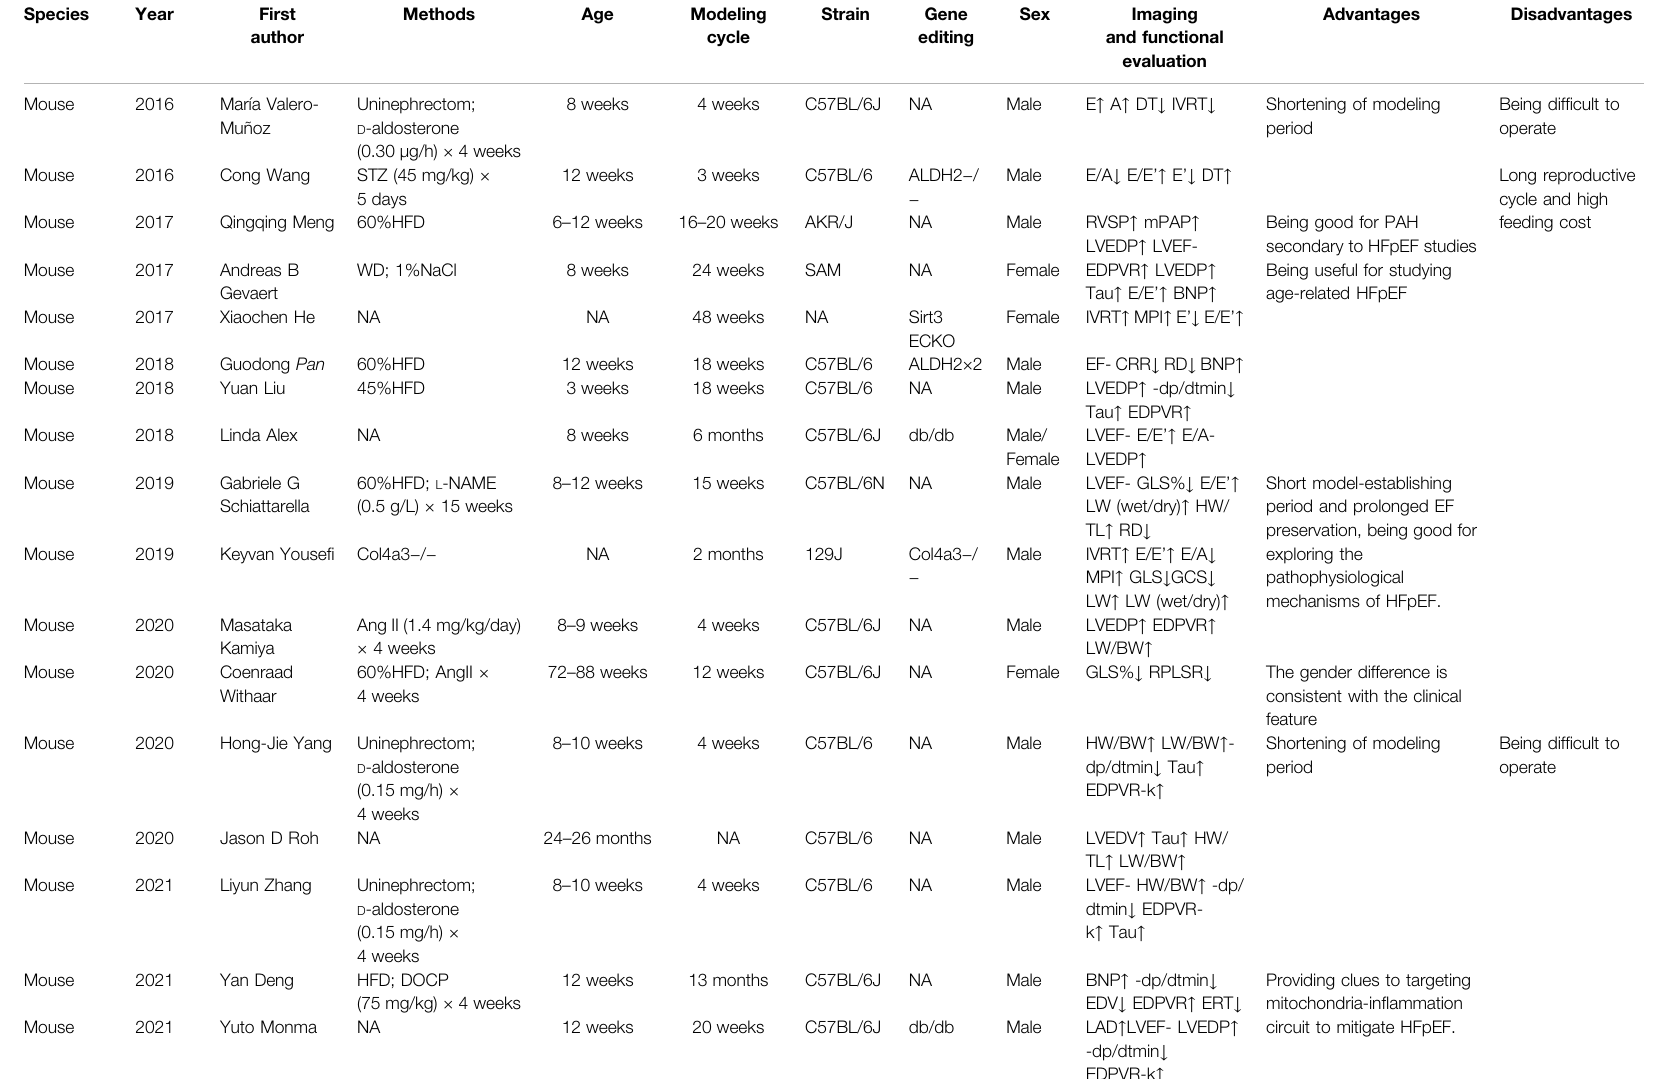
TABLE 1 | Animal models for heart failure with preserved ejection fraction and metabolic disorders.